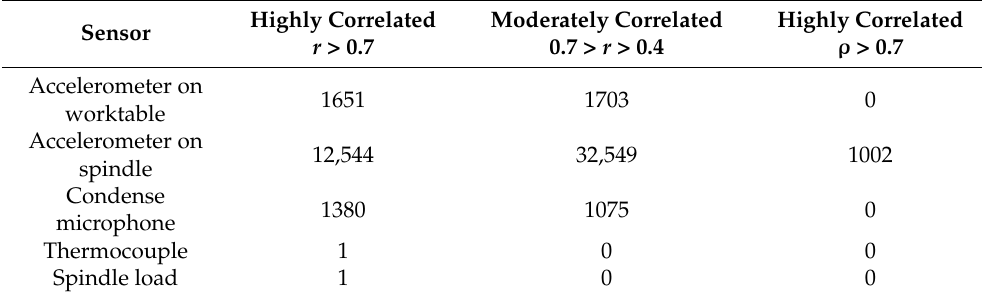
Table 3. Feature number of analysis results of Pearson and Spearman correlation